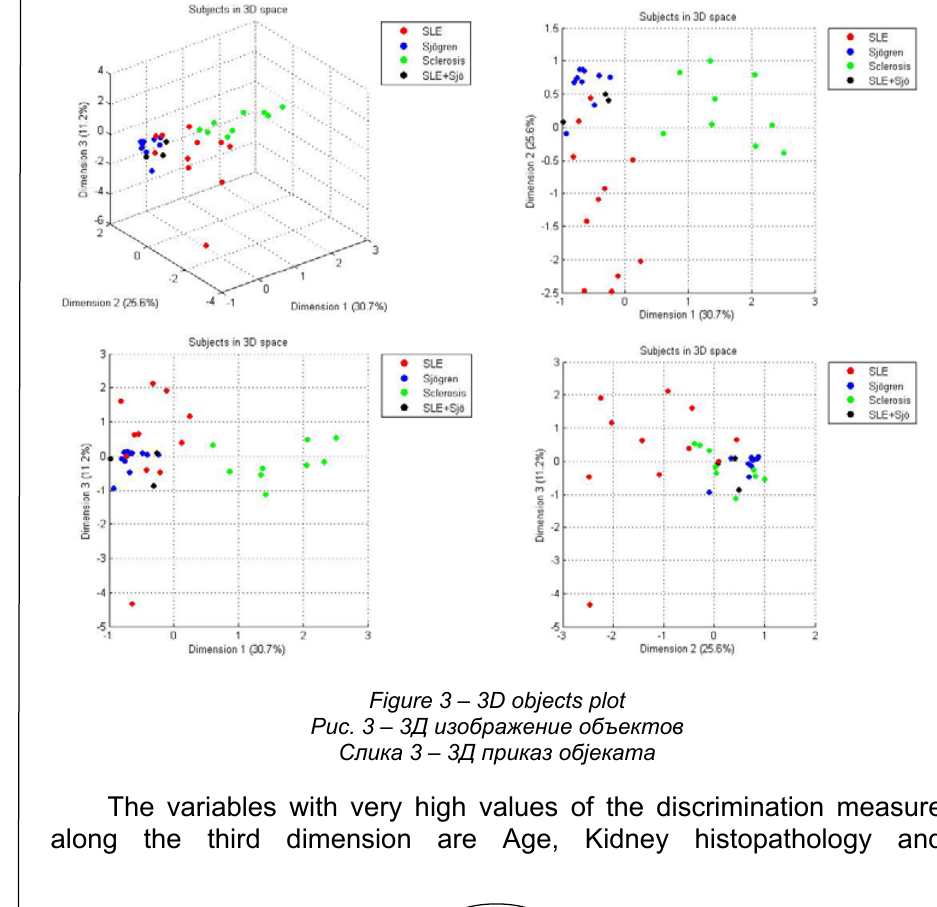
Figure 3 – 3D objects plot Рис . 3 – 3 Д изображение объектов Слика 3 – 3 Д приказ